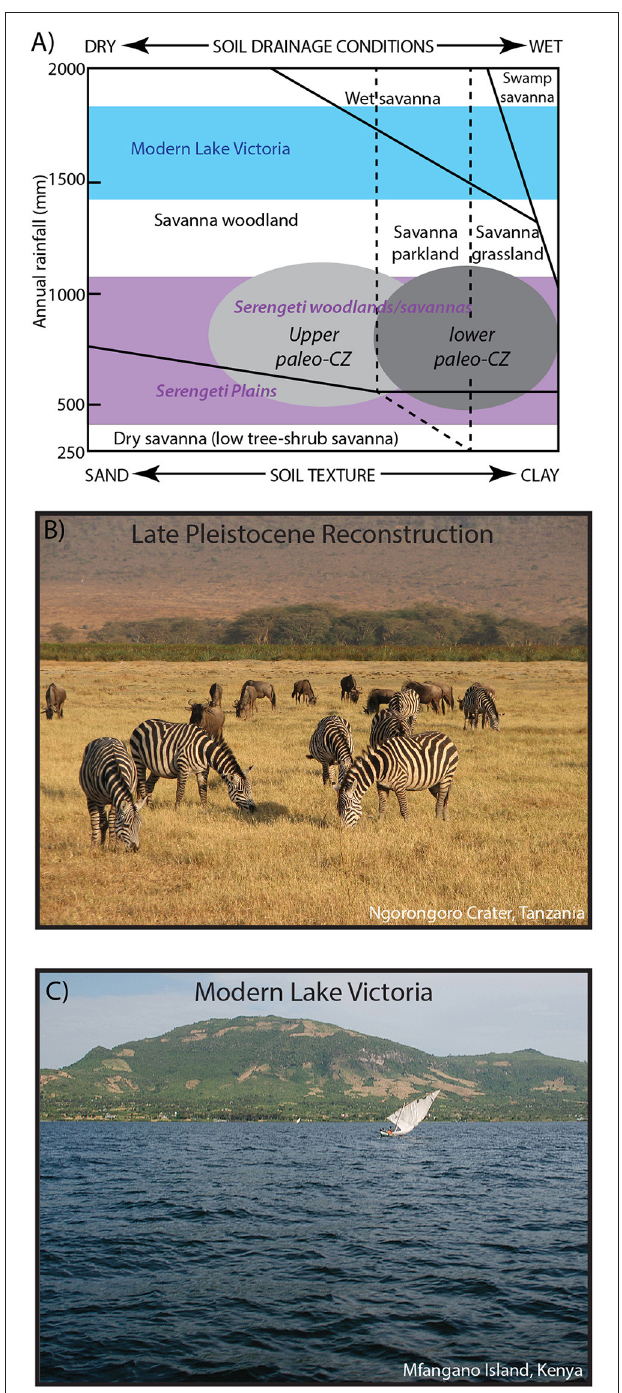
FIGURE 3 | (A) The Johnson/Tothill model of tropical savannas, which shows that both MAP and soil texture have a predictable effect on vegetation. The reconstructed paleo-CZs from the northeastern shoreline of Lake Victoria indicate an environment similar to a modern savanna woodland, parkland, or grassland based on MAP and grain size of the paleosols. The range of Serengeti woodlands/savannas and the Serengeti Plains are indicated in purple as well as the range of modern Lake Victoria precipitation in blue.